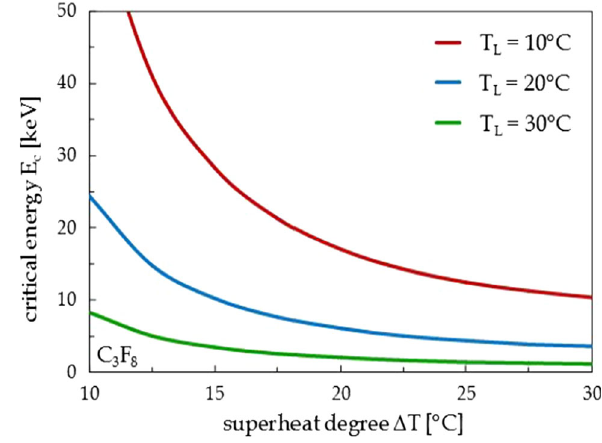
Fig. 5 Distributions of E c vs. (cid:4) T for C 3 F 8 using T L as a